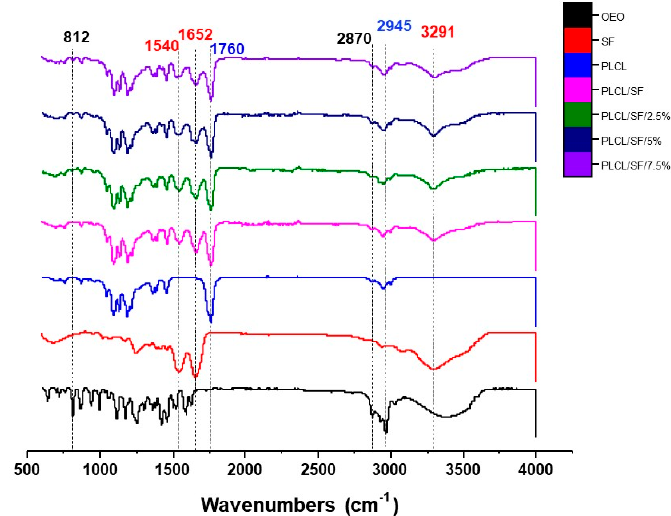
Figure 2. Attenuated total reflection Fourier transform infrared spectroscopy (ATR-FTIR) spectra of pure OEO, SF, PLCL and the electrospun Nano Fibrous membranes with 0%, 2.5%, 5%, and 7.5%)